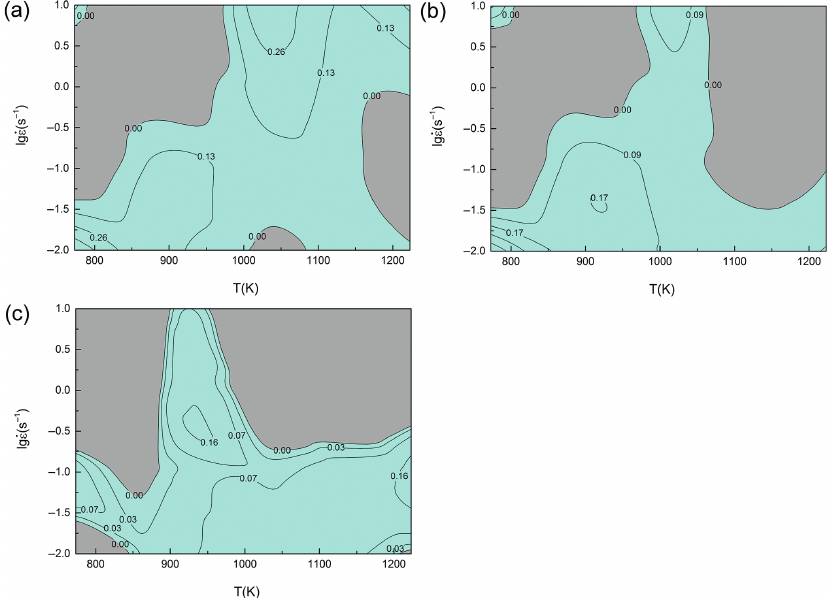
Figure 8: The instability maps of ultra-high strength steel BR1500HS at different strain value: (a) ε = 0.05, (b) ε = 0.10, (c) ε = 0.15.